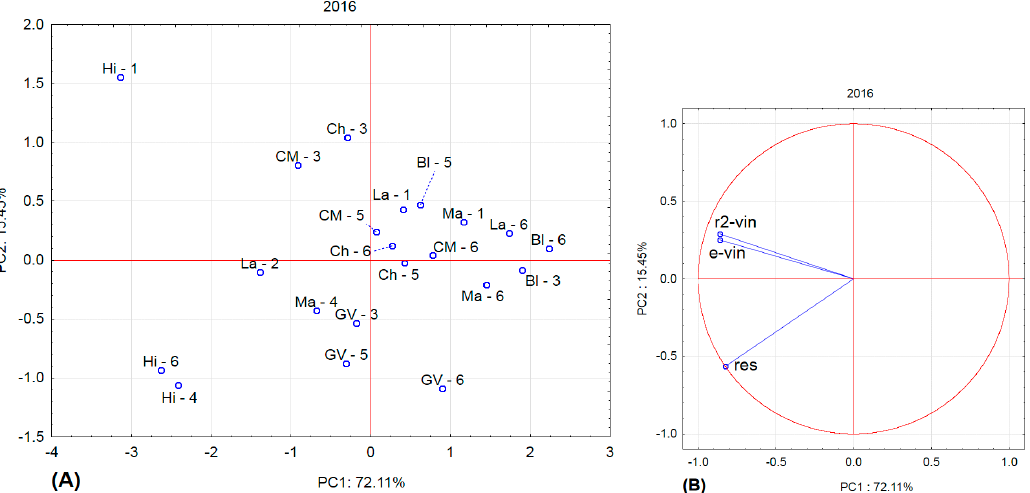
Figure 6. Principal component analysis for 2015. ( A ) projection of varieties and localities into component plane; ( B ) projection of component weights of stilbenes.